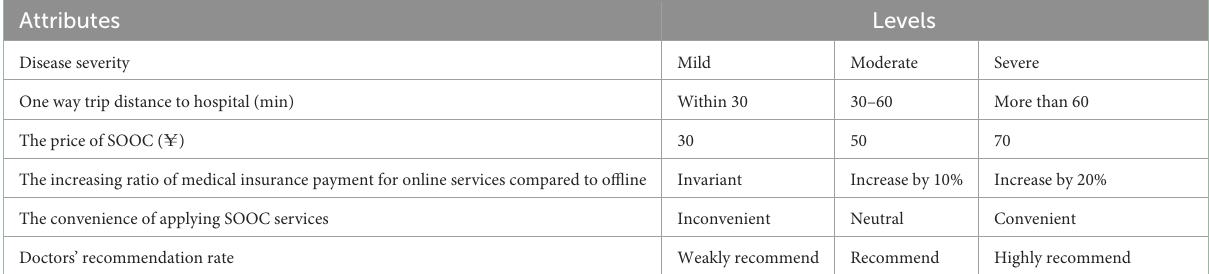
TABLE 1 Attributes and levels.